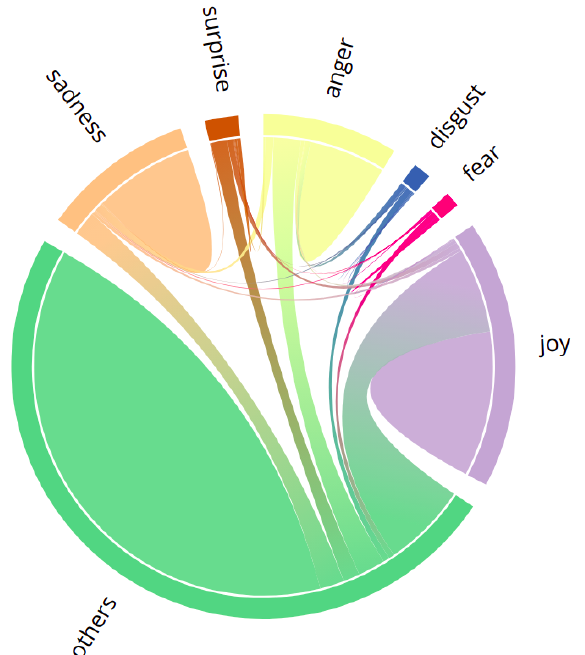
Figure 2. Chord diagram representing the confusion matrix for the best model. An incoming arc from class X to Y represents that class Y was expected, but X was